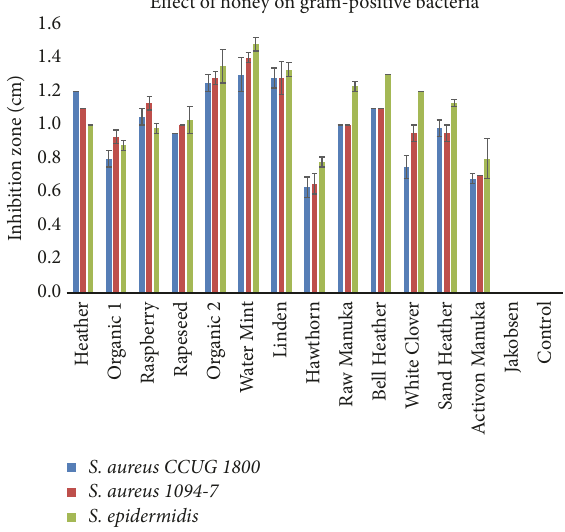
Figure 2: Effect of different floral sources of honey on growth of gram-positive bacteria (mean ± SD; n = 2).